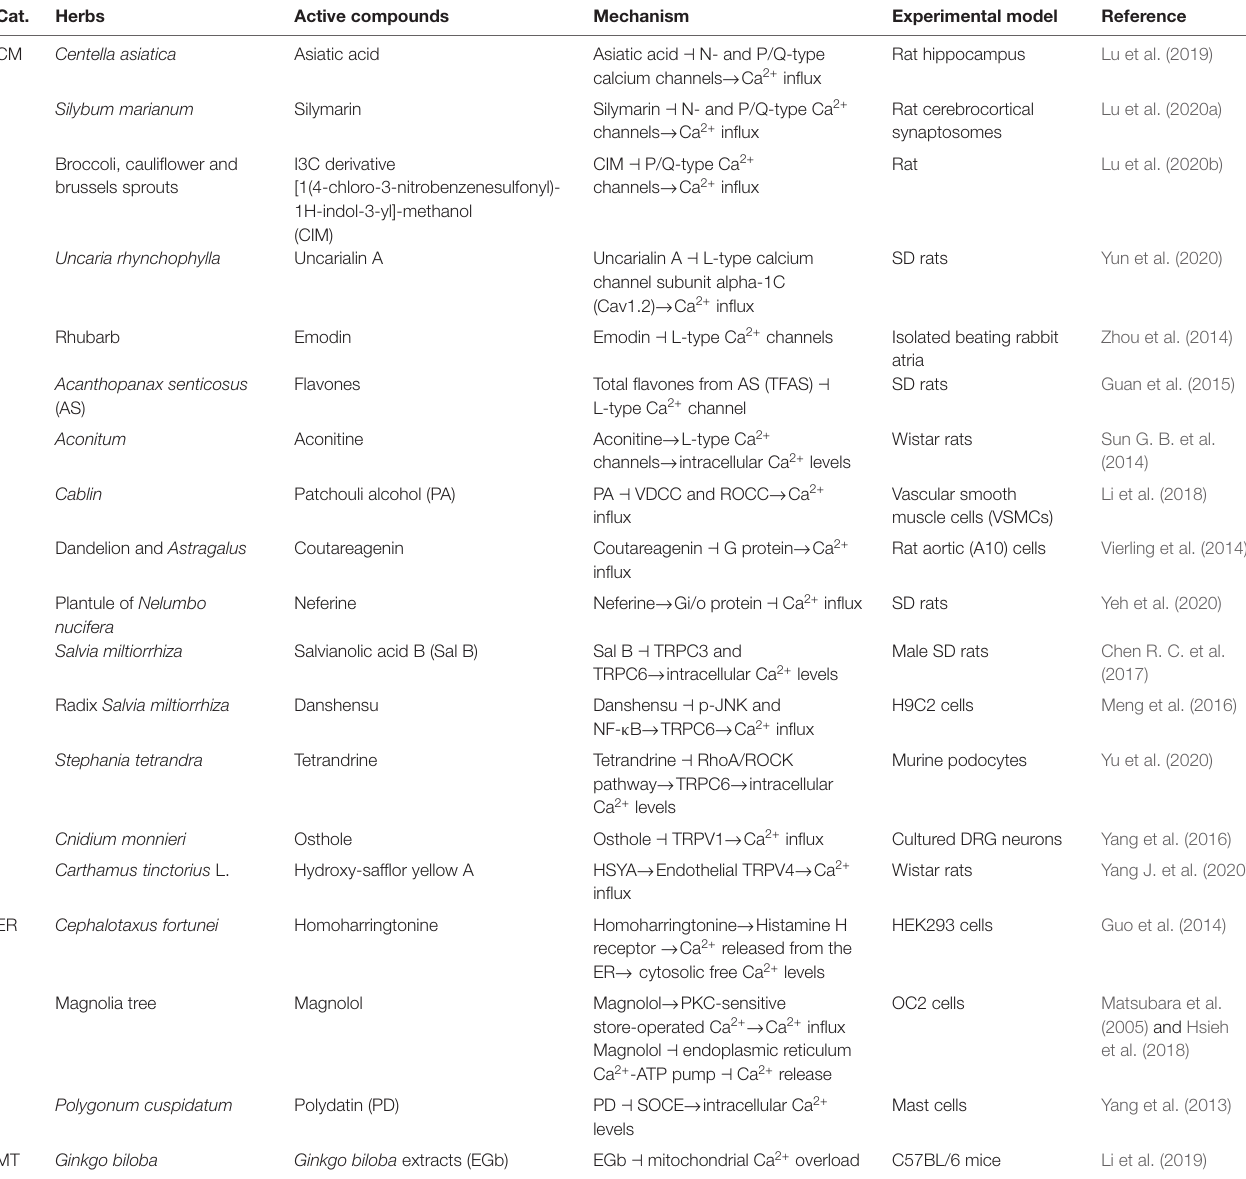
TABLE 6 | The effects of herbal medicines on regulating Ca 2+ dyshomeostasis.